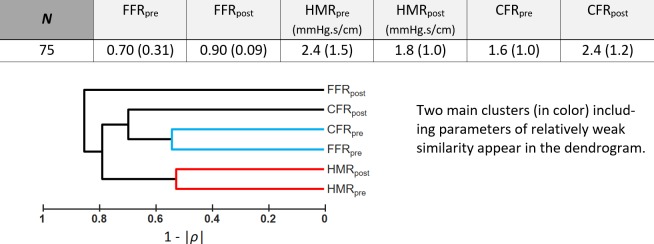
Hemodynamic parameters of the 2st dataset (n = 75).Same acronyms as in Fig 2. Subscripts “pre” and “post” refer to pre- and post-revascularization, respectively. Reported values = median (interquartile range).